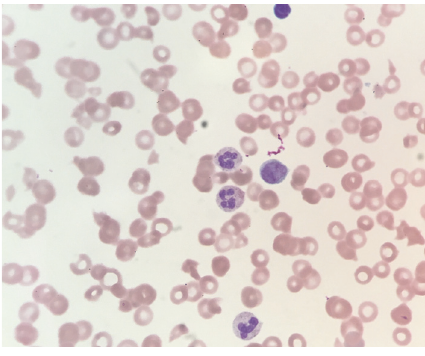
Figure 1: Peripheral